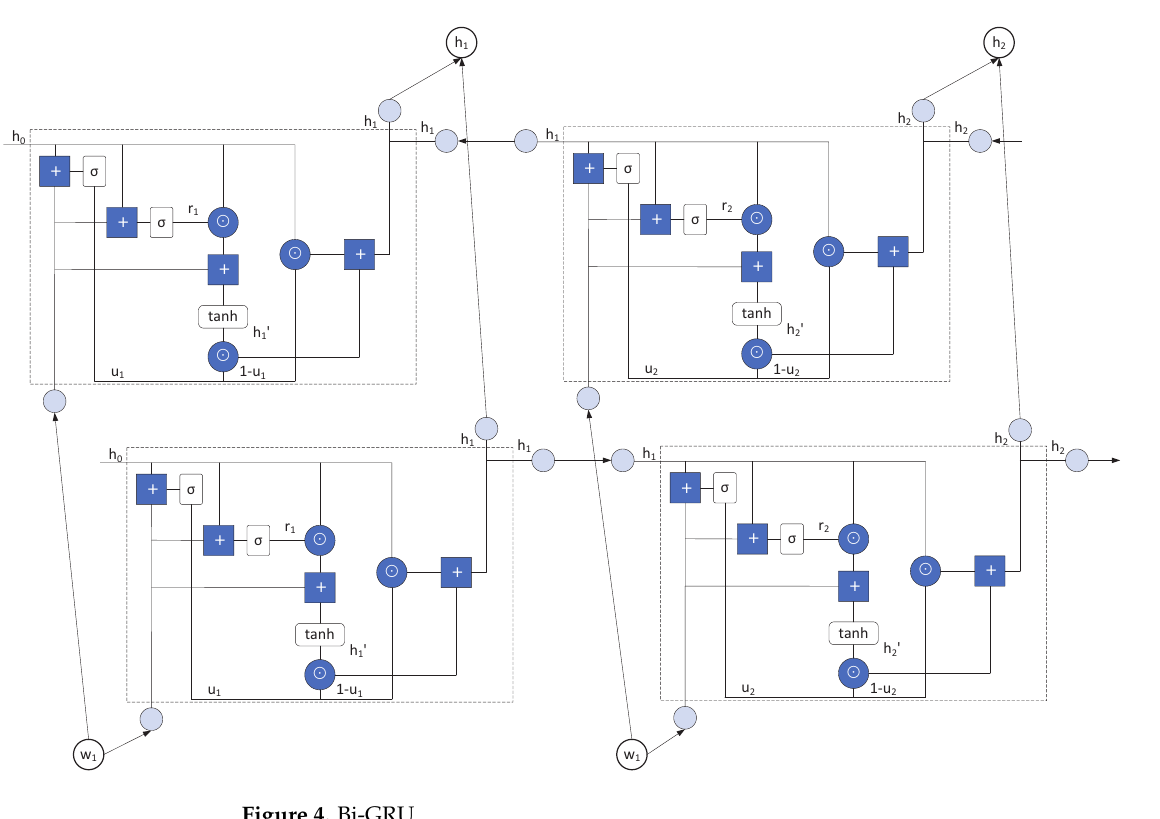
Figure 4. Bi-GRU.